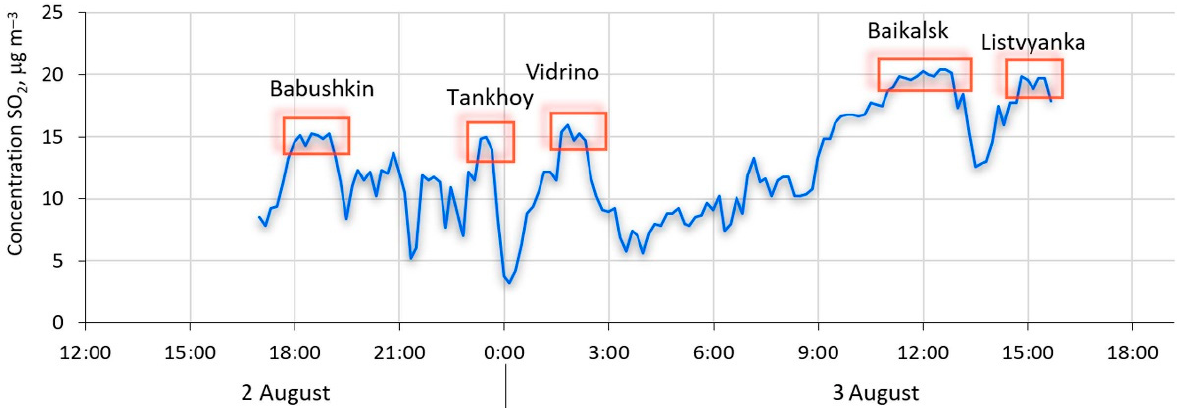
Figure 10. Temporal variation of sulfur dioxide concentration over the water area of Lake Baikal along the southeastern coast in the period 2–3 August 2019.